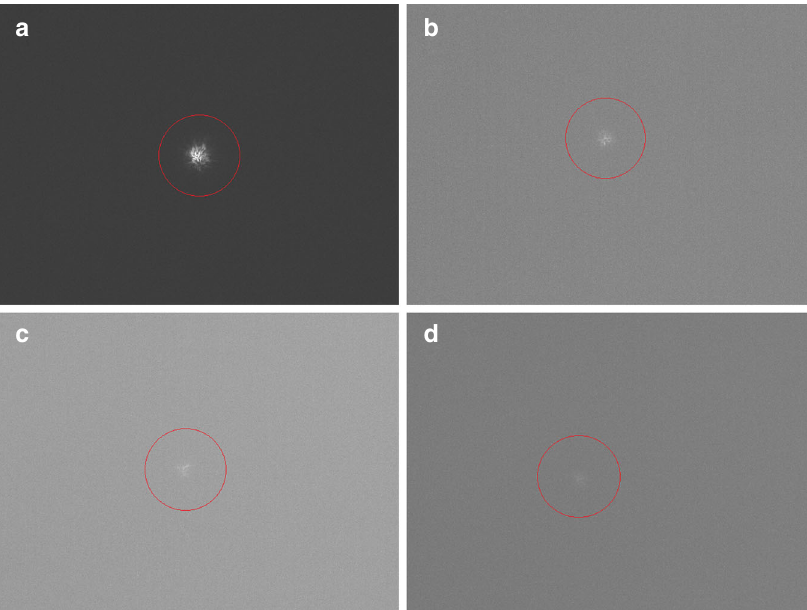
Fig. 4 Visualization of stars during daylight. Daylight observations of stars of the Hipparcos (HIP) catalog with magnitudes (m). The images were taken with an ASI120 between 12:14 and 13:43 UTC at sun elevations between 10° and 18°. The images were cropped to a fi eld of view of 1.7 × 1.1 arc min. Red circles highlight the star images for easier recognizability. a HIP69673 ( m = 0.15, az = 255°, el = 39°), b HIP71075 ( m = 3.00, az = 277°, el = 50°),